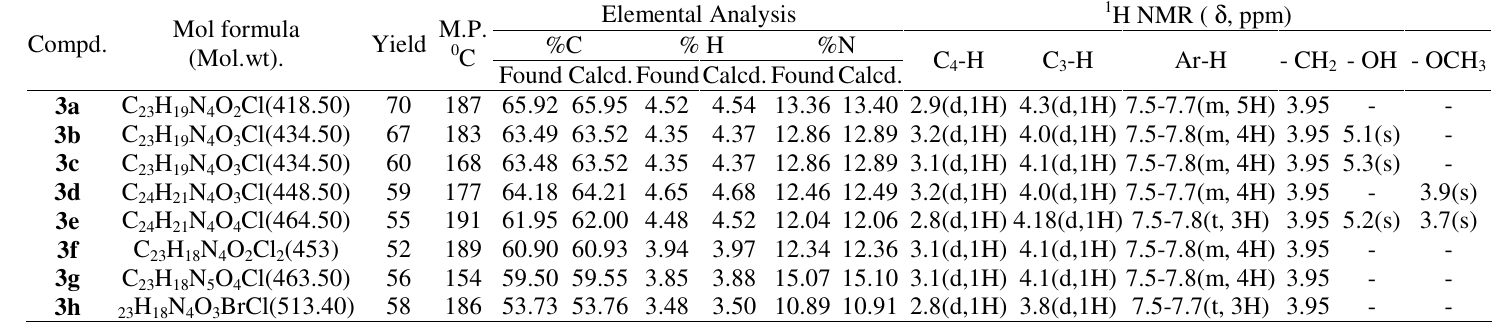
Table 2. Analytical and Spectral Data of Compounds ( 3a-h